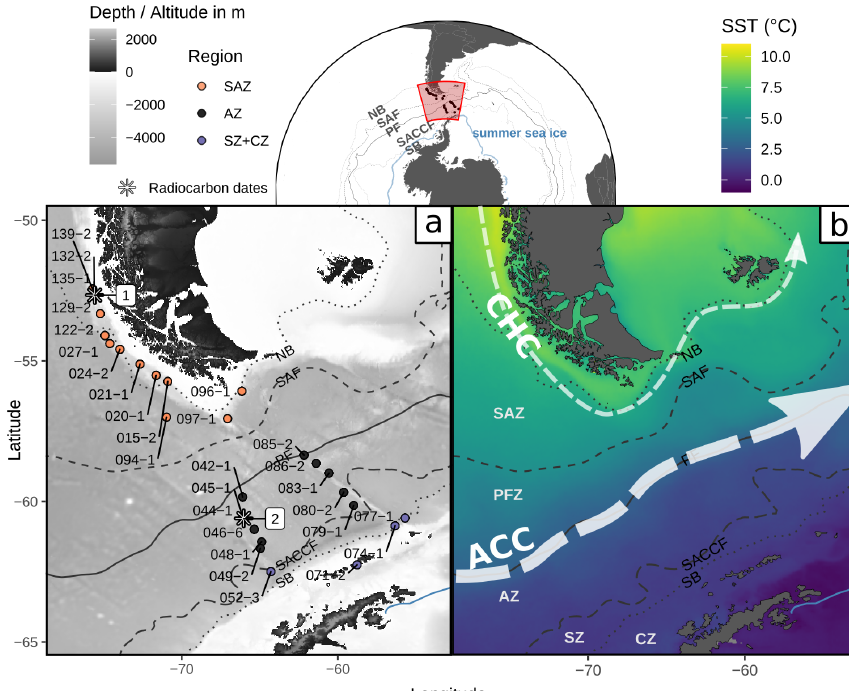
Figure 1. Study area in the Drake Passage, Southern Ocean, showing (a) locations of the studied surface sediment samples from expedition PS97 (Lamy, 2016) and radiocarbon dates (1 from Caniupán et al., 2011b, and 2 from Vorrath et al., 2019) and a bathymetric map from ETOPO1 (Amante and Eakins, 2009) and (b) a sea surface temperature composite (MODIS Aqua 2002–2020 cumulative L3m 4km product distributed by the Ocean Biology Distributed Active Archive Center as AQUA_MODIS.20020704_20200831.L3m.CU.SST.sst.4km.nc based on NASA/JPL, 2020) with main currents after Lamy et al. (2015) and Kaiser et al. (2005): CHC (Cape Horn Current) and ACC (Antarctic Circumpolar Current). Dotted and dashed lines depict the ACC fronts (from Park and Durand, 2019) from north to south the following: NB (Northern Boundary, resembles the STF), SAF (Subantarctic Front), PF (Polar Front), SACCF (Southern ACC Front) and SB (Southern Boundary). Areas between the ACC fronts are the SAZ (Subantarctic Zone), PFZ (Polar Frontal Zone), AZ (Antarctic Zone), SZ (Southern Zone) and CZ (Continental Zone). Blue line depicts the approximate summer sea-ice extent (Sea Ice Index, Version 3, Fetterer et al., 2017). Base map dataset from Natural Earth (https://naturalearthdata.com, last access: 27 April